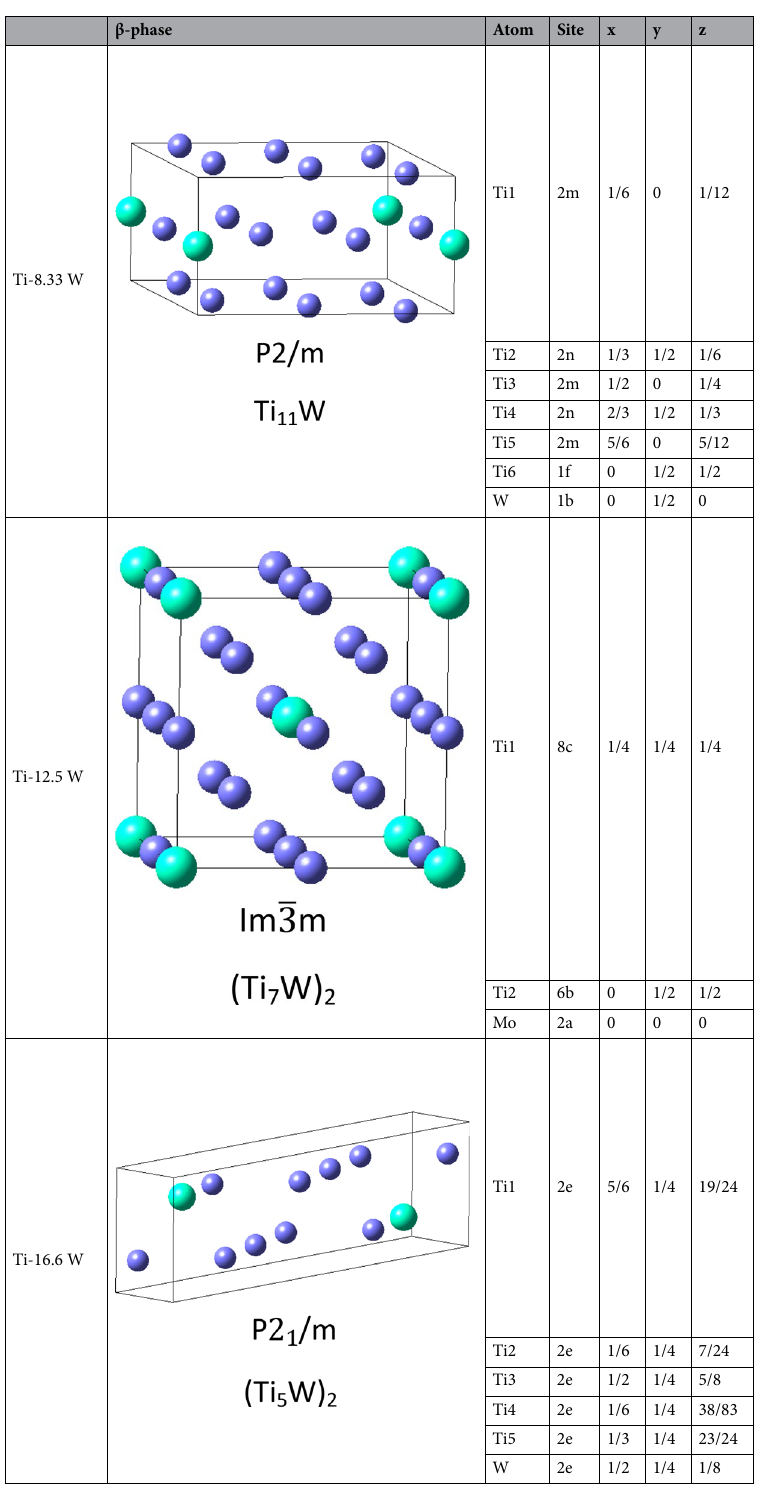
Table 1. CE predictions of stable β-phase structures for Ti–W binary system at various compositions. The blue and green atoms are Ti and W